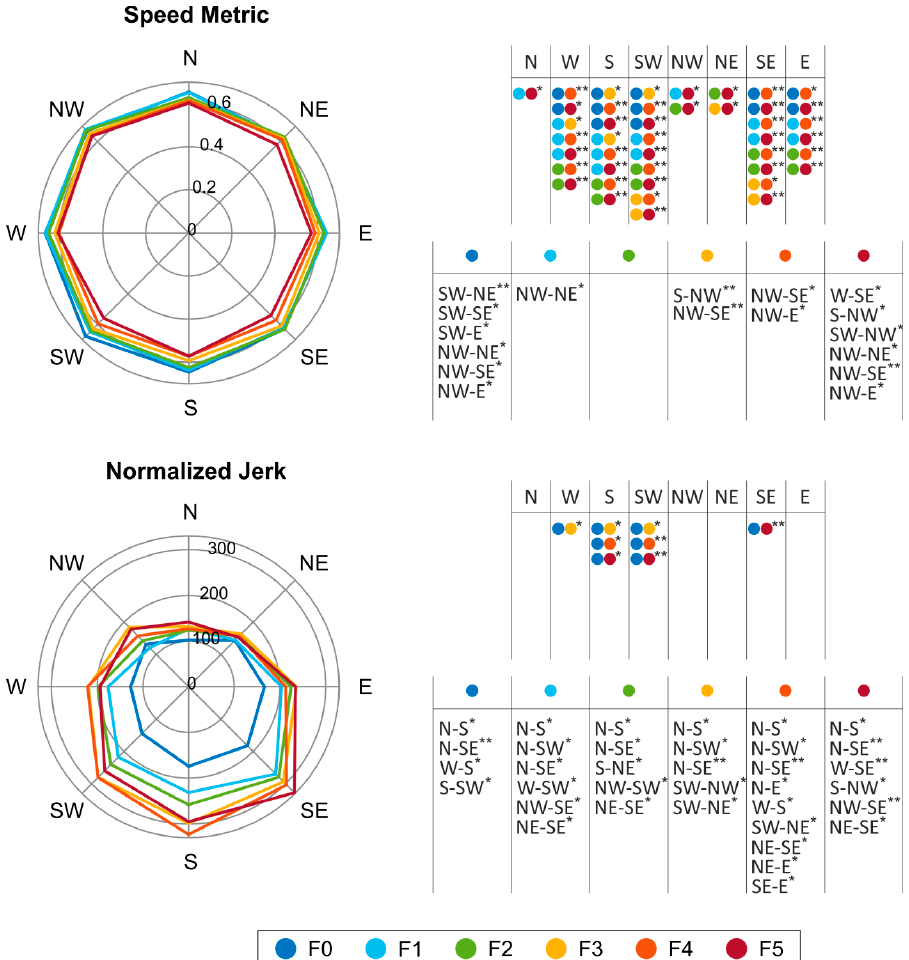
Figure 4. Speed Metric (SM) and Normalized Jerk (NJ): mean values among subjects and repetition for each force and each direction on the left; the interaction factor was significant and on the right the one-way ANOVA results: differences between the direction and between the force. (‘*’ represents p -value <0.05; ‘**’ represents for p -value